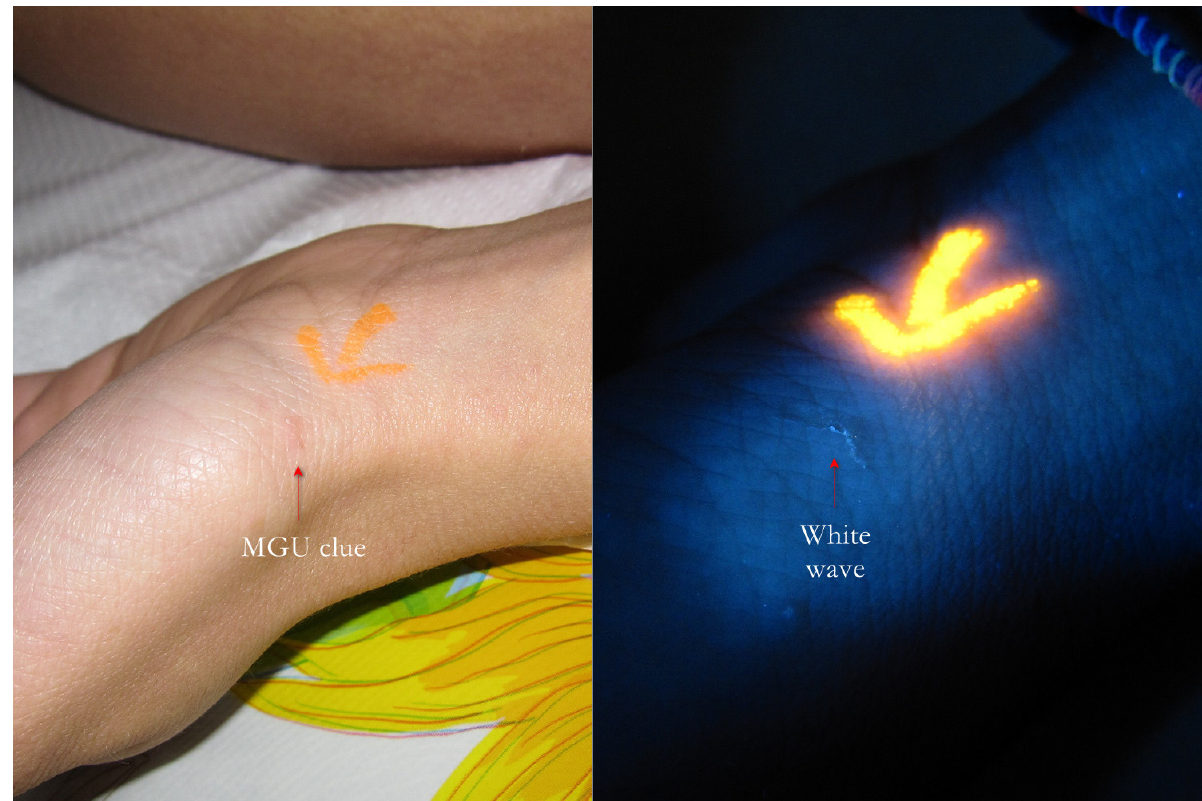
Figure 6. Flash light vs. UVA. The burrow was a clue (left red arrow) that under UVA light, a very clear linear structure (white wave) formed, suggesting a typical Mite ‐ Gallery Unit ( right ). A yellow highlighter was used.